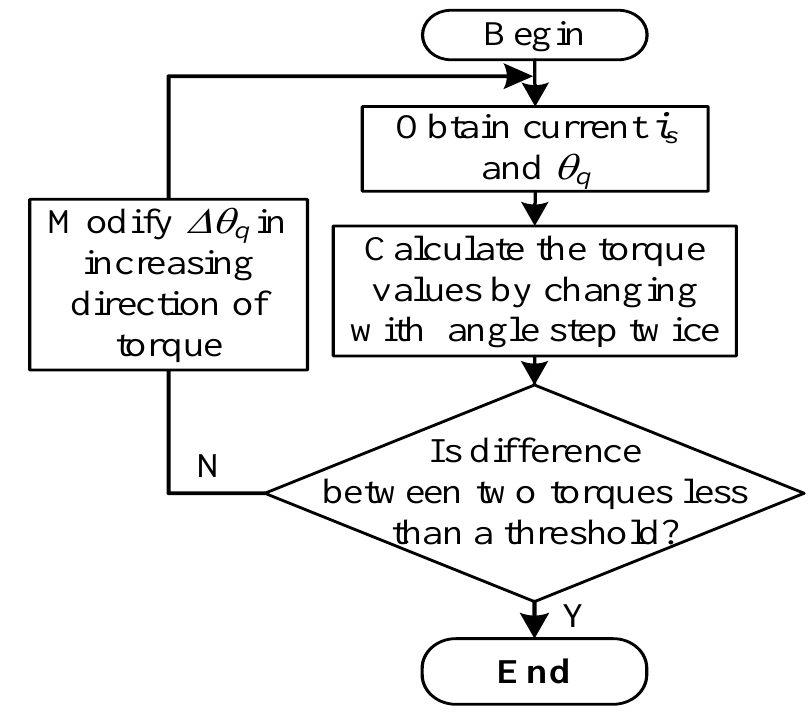
Figure 14. Current angle optimization process.